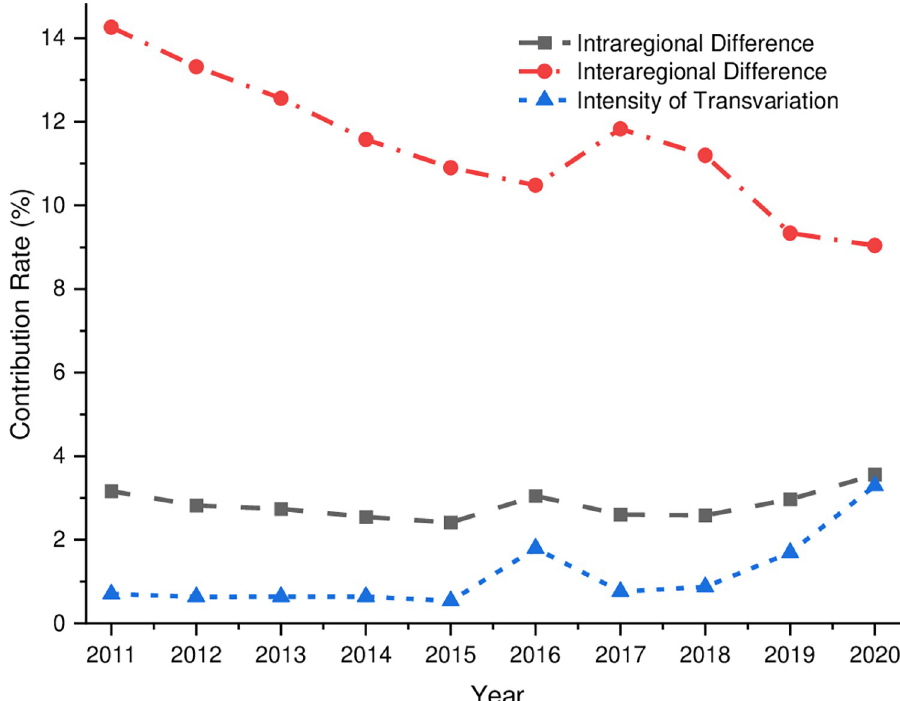
Fig 8. Breakdown of sources of